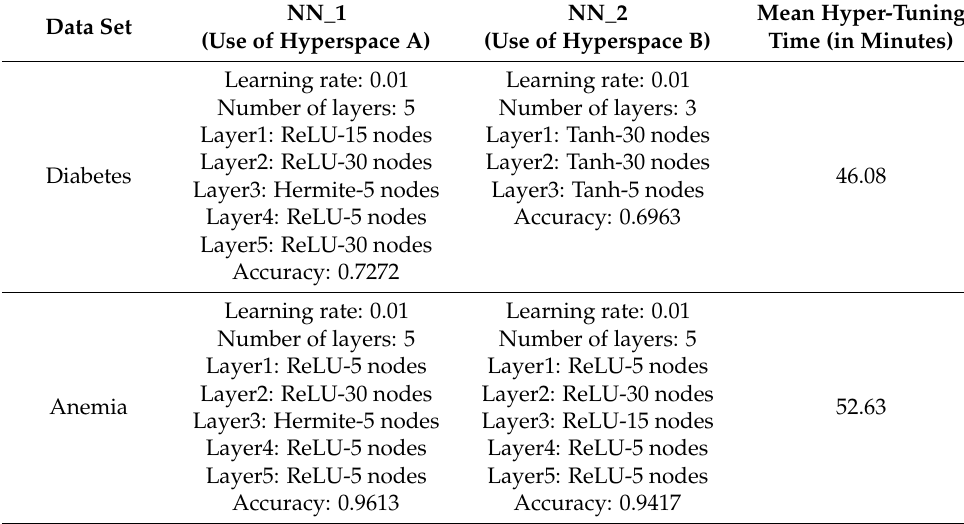
Table 11. (Third Experiment-Second Simulation Case) Optimal hyperparameter values, classification (i.e., validation) accuracy evaluated on the validation data, and the mean time needed to perform the hyperparameter optimization (i.e., mean hyper-tuning time) obtained by the best neural network (NN_1) using the Hyperspace A, and the best neural network (NN_2), using Hyperspace B (Data sets: Diabetes, and